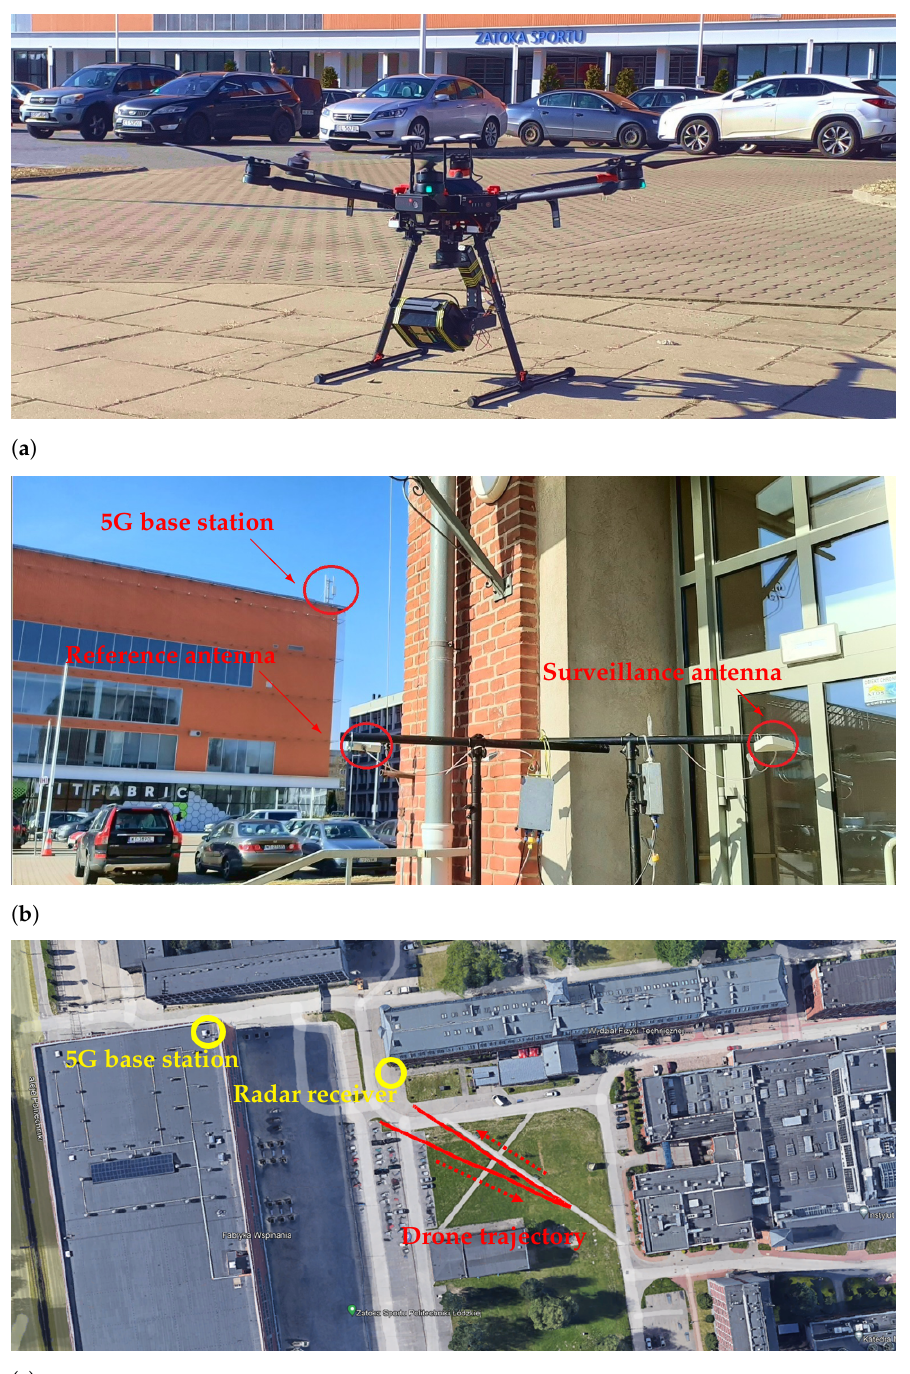
Figure 18. Drone and the recorder during the trials with the drone trajectory superimposed on the map. ( a ) Cooperative target. ( b ) Measurement setup. ( c ) GPS trajectory of the drone. The red dashed arrows indicate the drone’s direction of